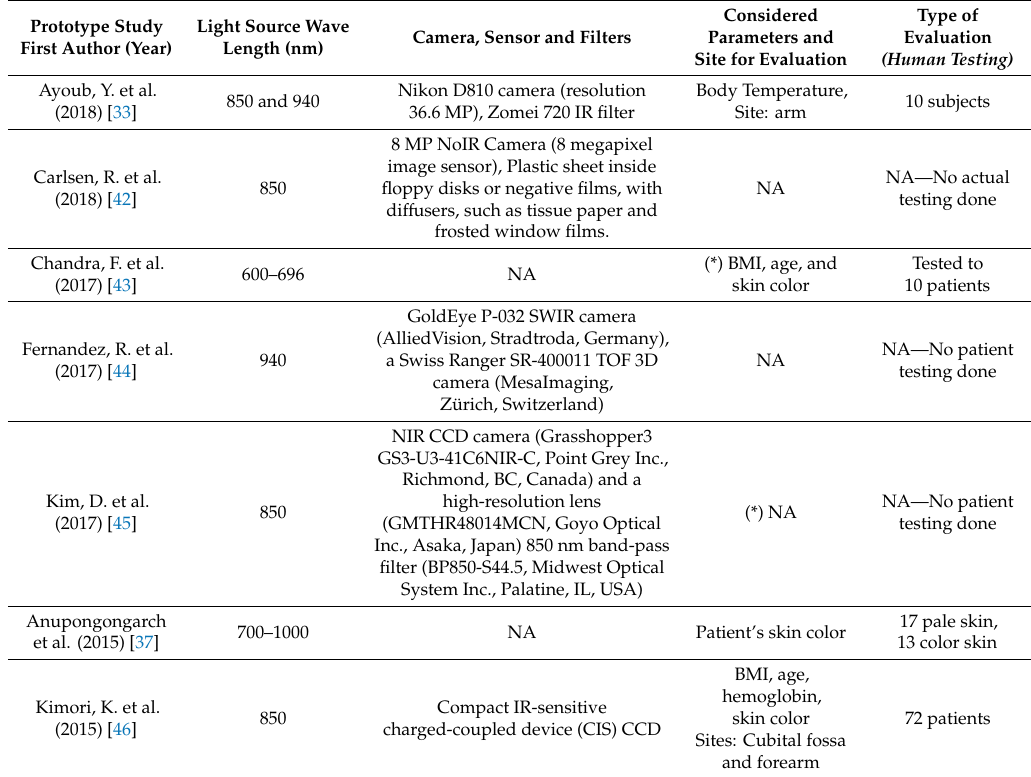
Table 2. Characteristics of the different prototypes.